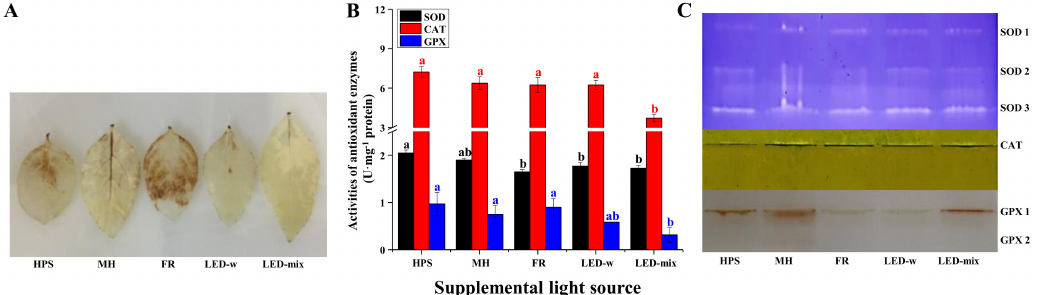
Figure 5. Localization of hydrogen peroxide (H 2 O 2 ) in the leaves of C. lanceolata ( A ), the activities ( B ) and the expression analysis of antioxidant enzymes by native PAGE ( C ). Different small letters indicate the significant separation within treatments by Duncan’s multiple range test at a 0.05 level.